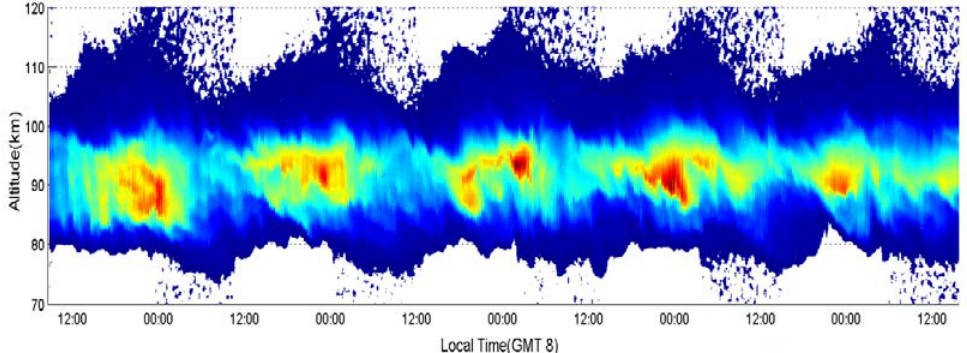
Figure 7. Five complete diurnal cycles of observation by sodium lidar at Beijing Yanqing lidar station.